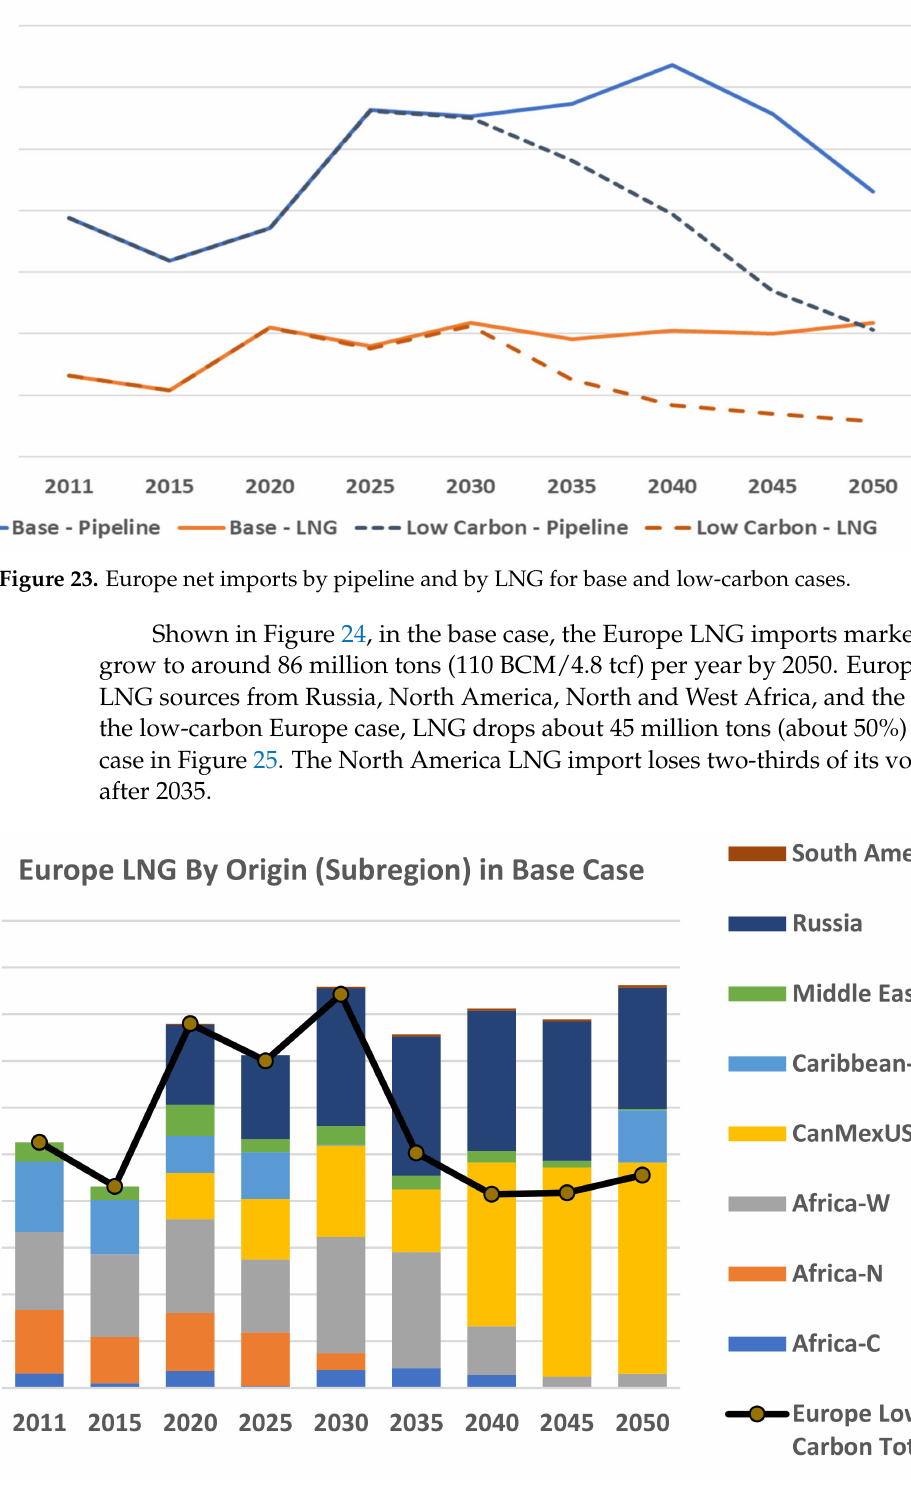
Figure 24. Europe total LNG by origin in base case vs. low-carbon case (1.0 million tons of LNG ≈ 1.3 BCM ≈ 48